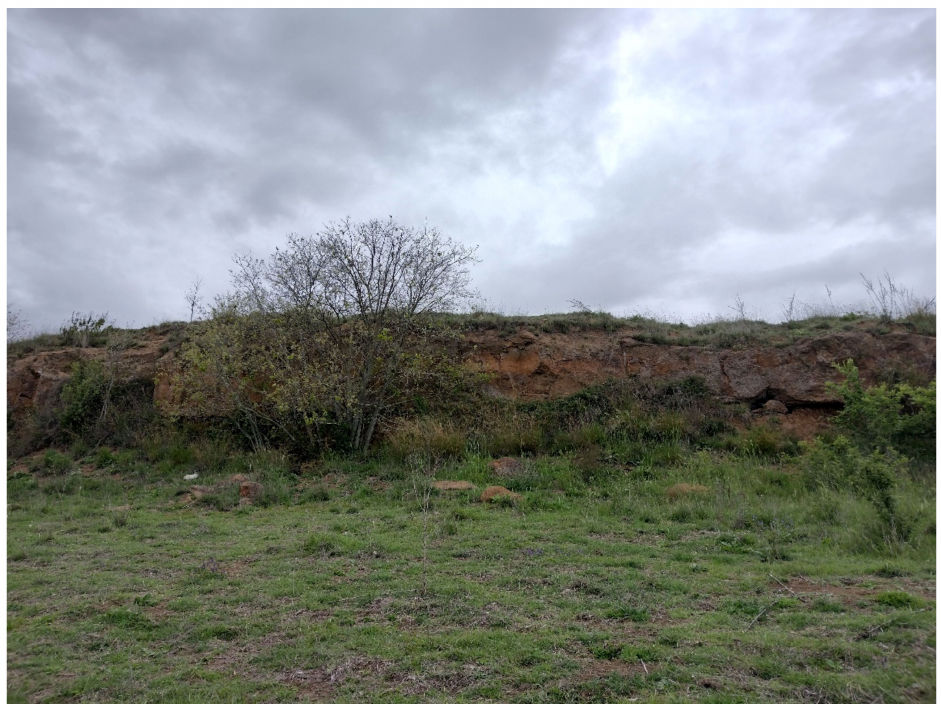
Figure 3. Unconsolidated pyroclastic deposits ( Pozzolane ) in the northwestern sector of Caffarella valley (north of the